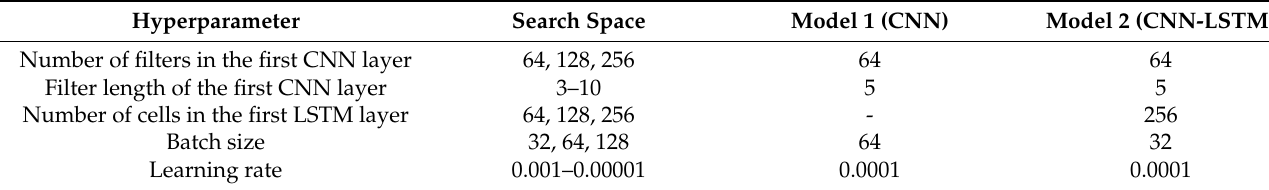
Table 1. Optimized hyperparameters applied to the models.